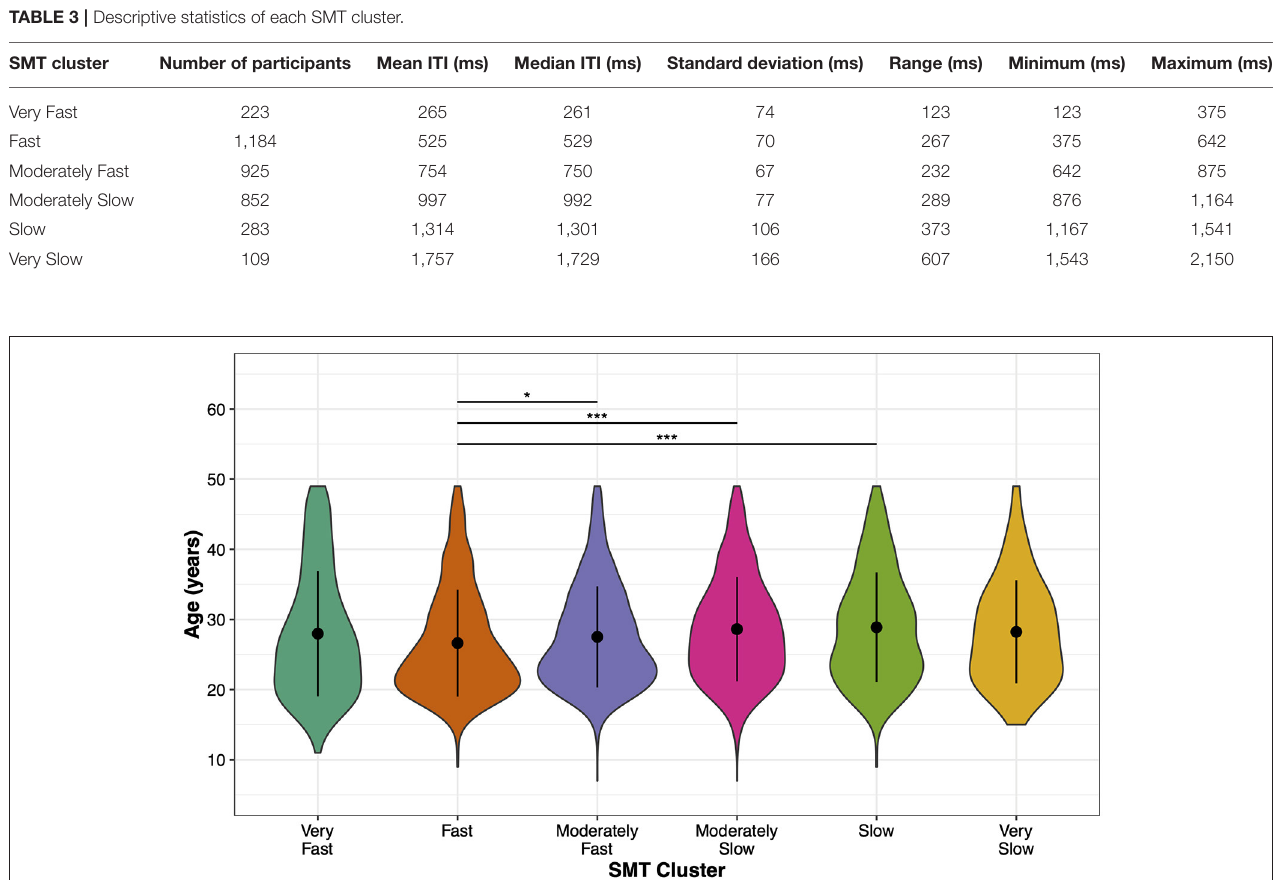
Frontiers in Psychology |